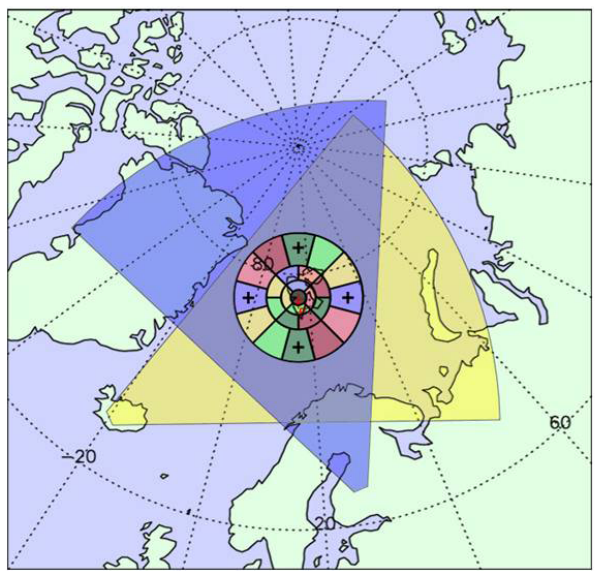
Fig. 1. The SCANDI field-of-view overlaps that of the ESR and SPEAR radars, and is also within the fov of the CUTLASS radars. The radars measure ionospheric parameters while SCANDI mea- sures co-located thermospheric